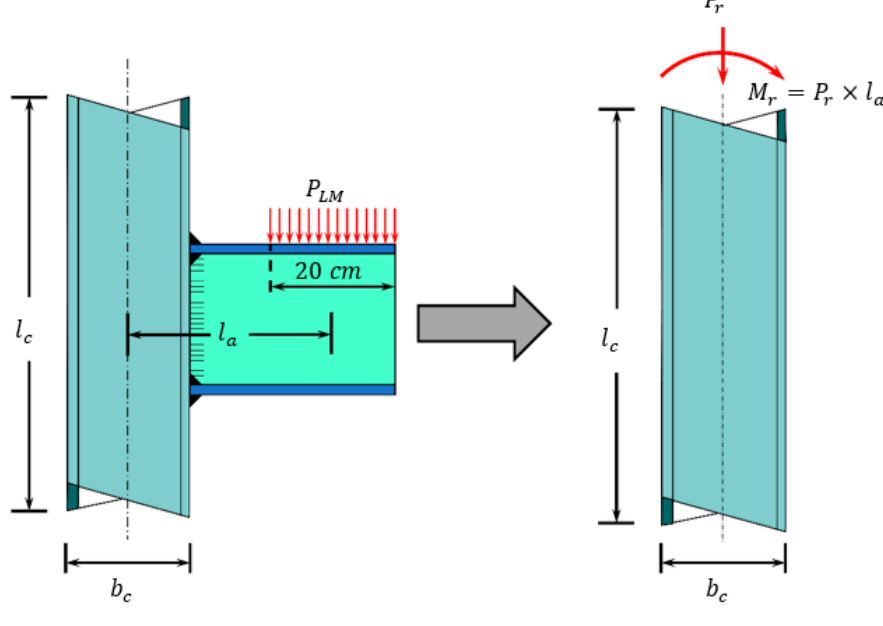
Figure 3. IBBC model with transferred crane load.